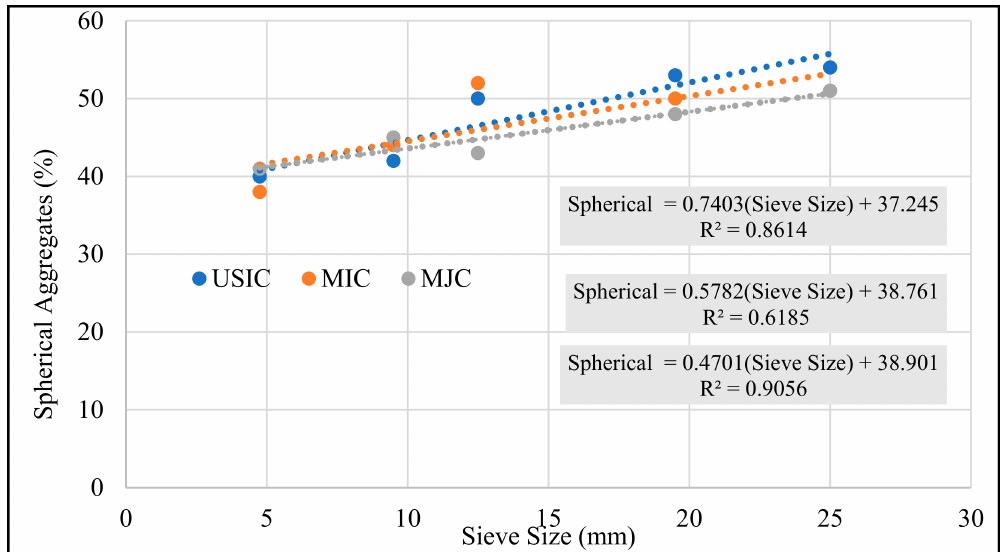
Figure 11. Effect of spherical shape aggregates on type of